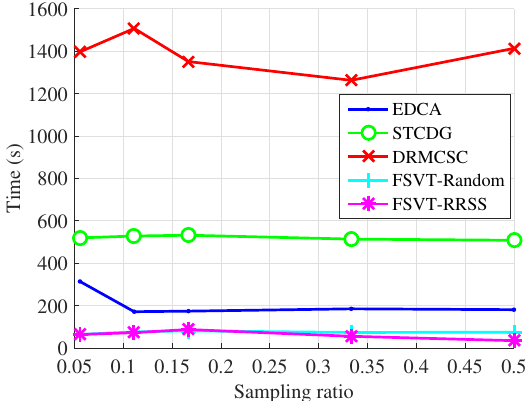
Figure 6. Running time over sampling ratio for the temperature from Intel Berkeley Research Lab.